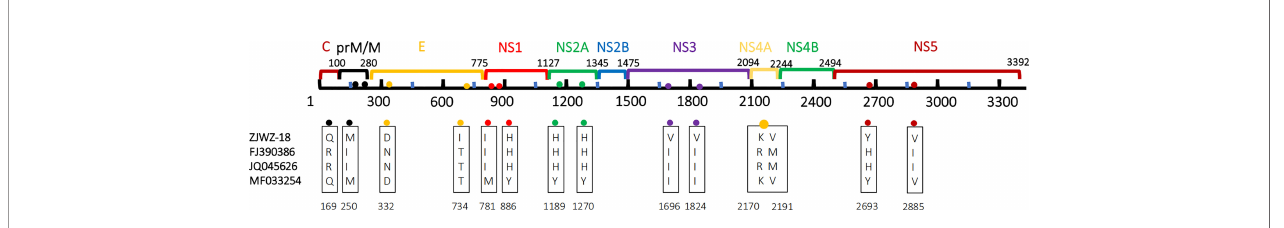
FIGURE 6 | Amino acid mutations between CDS of Wenzhou local strain and 3 closed phylogenetic strains. The labeled numbers represent the amino acid position.